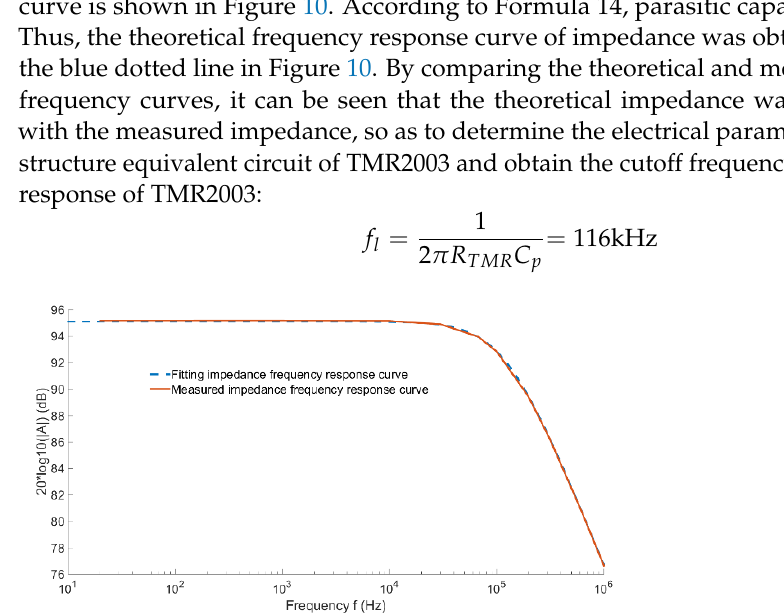
Figure 9. TMR sensor ring array layout diagram.